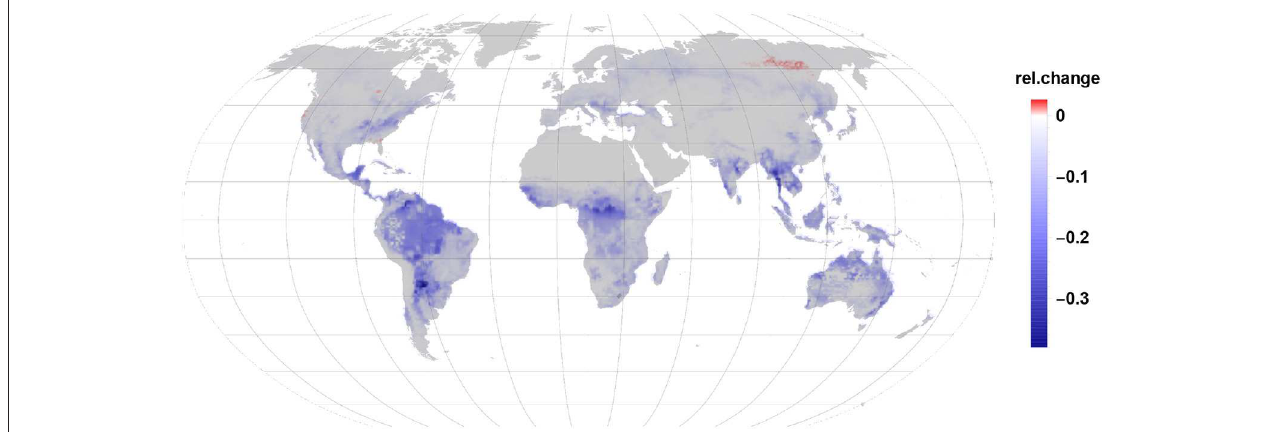
FIGURE 2 | Global impact of gall-forming insects on BVOC emission from broad-leaved